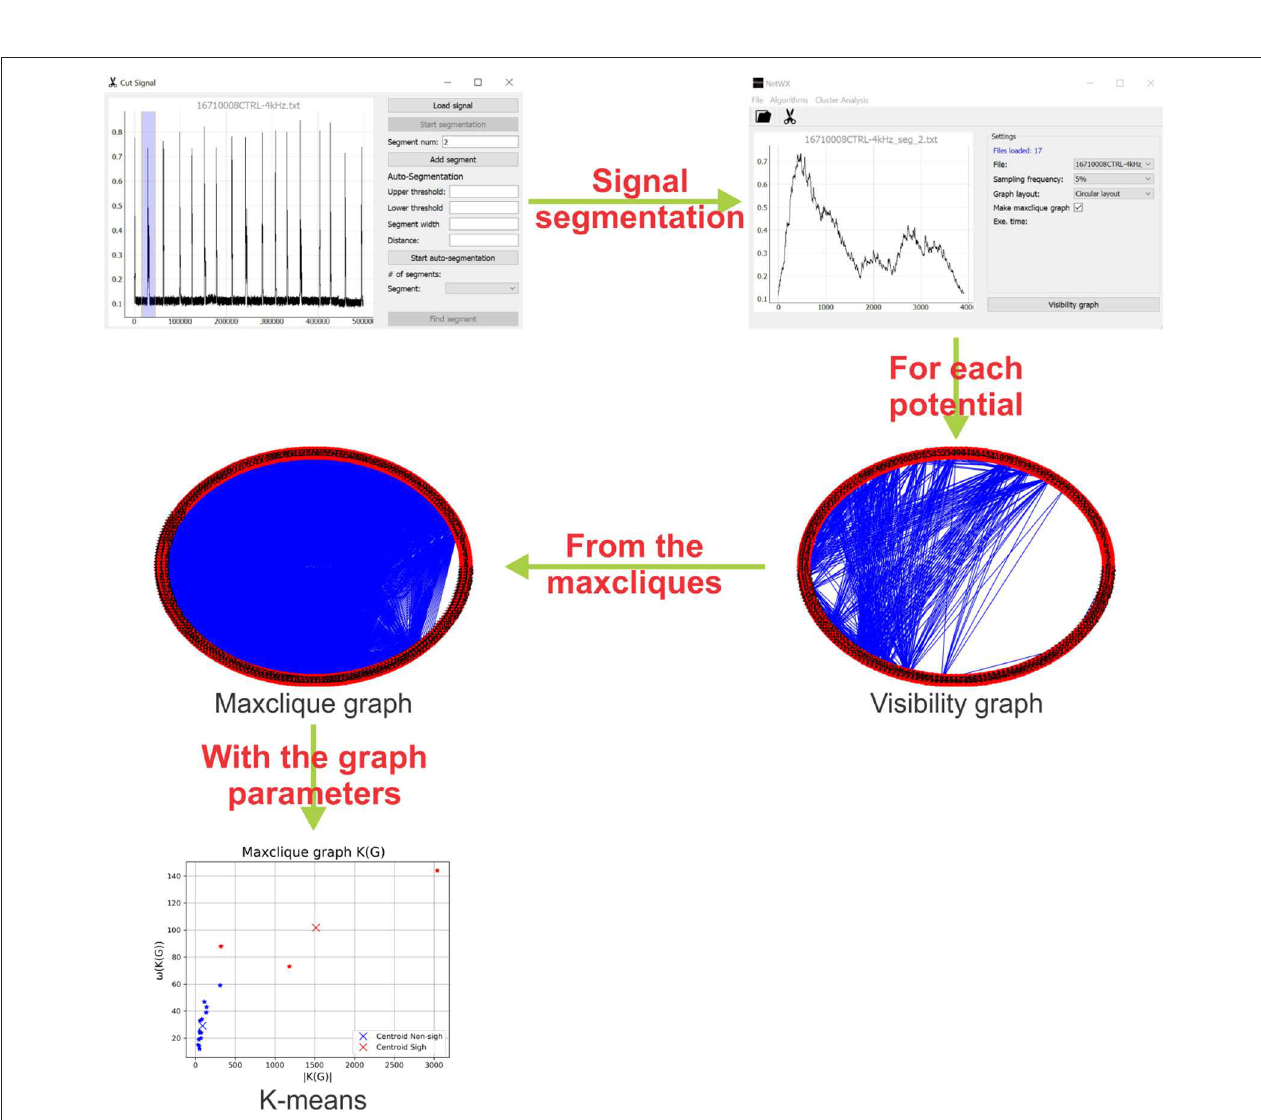
FIGURE 3 | Schematic representation of the methodology. First, the interface identify and segment each potential of the electrophysiology recording. Then, a visibility graph is created for each potential, for large signals a reduction of the sampling frequency is recommended. After that, from the maxcliques determined of the visibility graph, the maxclique graph is created and its parameters are estimated. Finally, a K-means clustering is performed on the maxclique graph parameters. In this work, the result is a classification of the potentials as sighs or non-sighs.